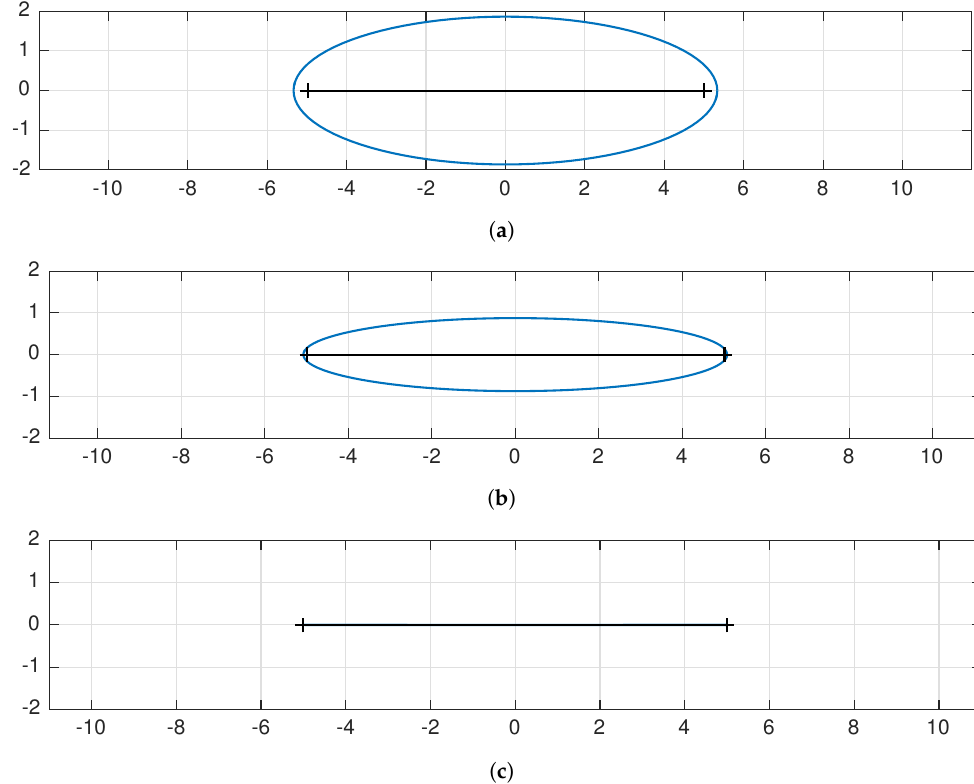
Figure 15. Bernstein ellipses for different points at the frequency response. According to Bernstein theorem convergence speed of analytic functions is controlled by the ρ coefficient which is the sum of lengths of both semiaxes. Approximated function is analytic for all frequencies in the integration interval, but for low frequencies analyticity region is vanishingly small. ( a ) Bernstein ellipse for integrated function in (22) for the frequency ω = 10 5 rad/s. ρ coefficient is approximately 3 ensuring fast convergence. ( b ) Bernstein ellipse for integrated function in (22) for the frequency ω = 1 rad/s. ρ coefficient is approximately 2, which is still fast converging. ( c ) Bernstein ellipse for integrated function in (22) for the frequency ω = 10 − 5 rad/s. ρ coefficient is approximately 1, which causes convergence to be very